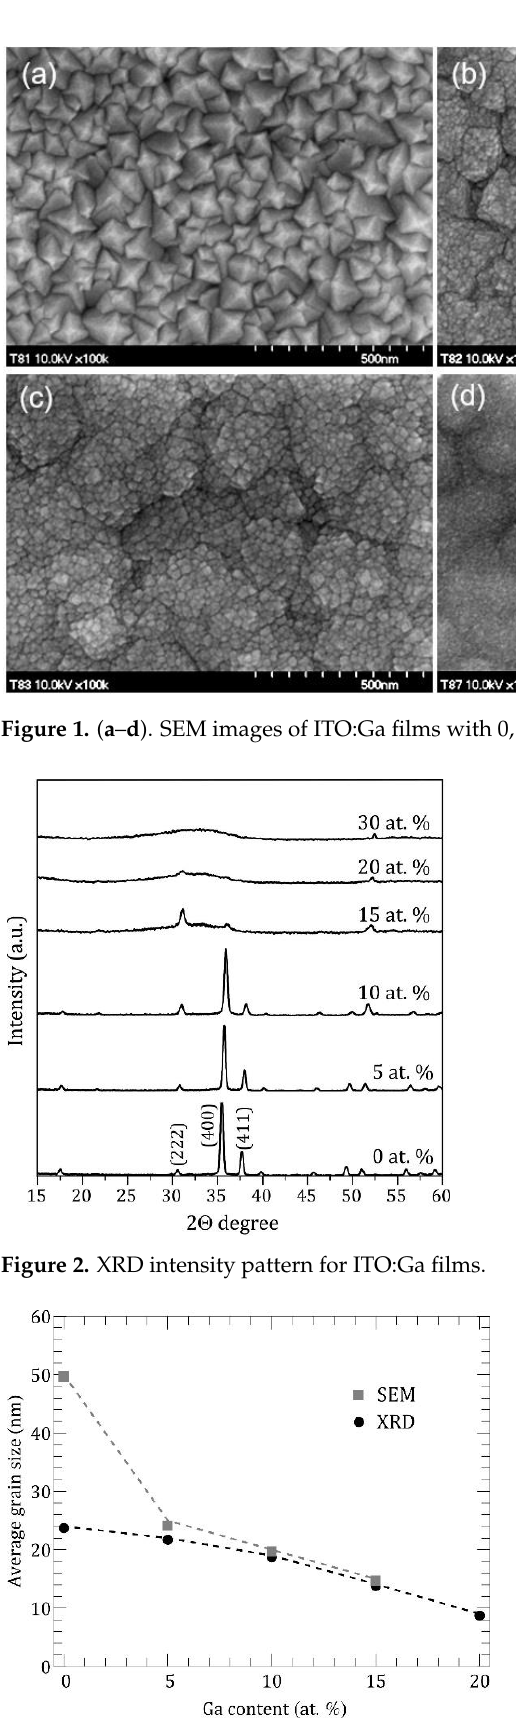
Figure 3. Average grain size in ITO:Ga thin films. Squares and circles denote SEM and XRD data, Figure 3. AveragegrainsizeinITO:Gathinfilms. respectively.